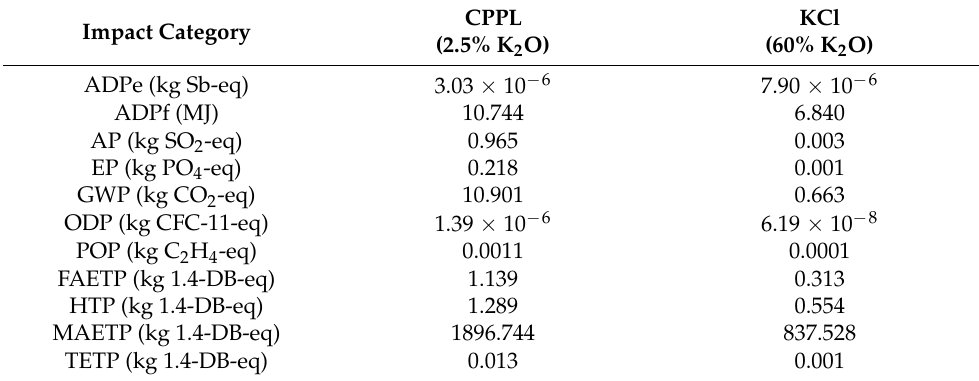
Table 10. Impact assessment of the production of 1 kg of the potassium substance. Impact